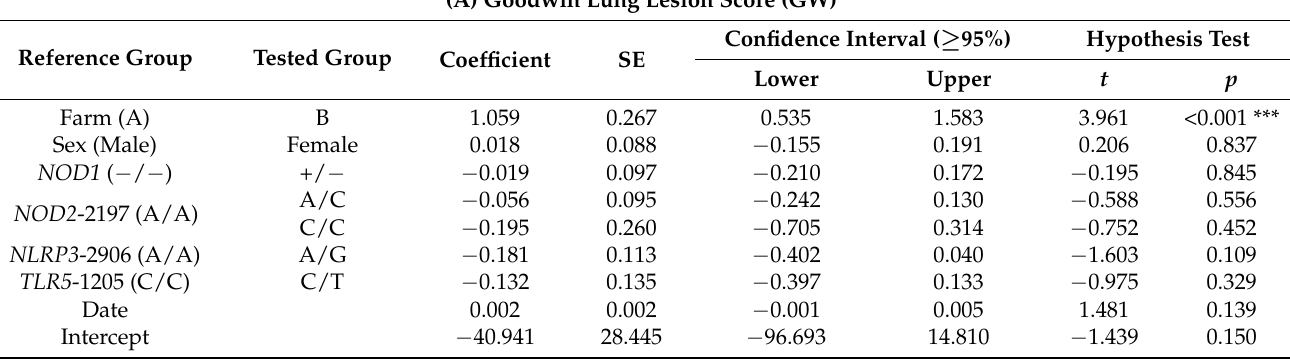
Table 5. PRR genotype–trait associations based on GLM analysis. (A) Goodwin lung lesion score; (B) SPES pleuritis lesion score; (C) backfat thickness; (D) intramuscular fat; and antibodies specific to (E) Mhp and (F) App. Farm, sex, and slaughter date were included as factors. The single NOD1